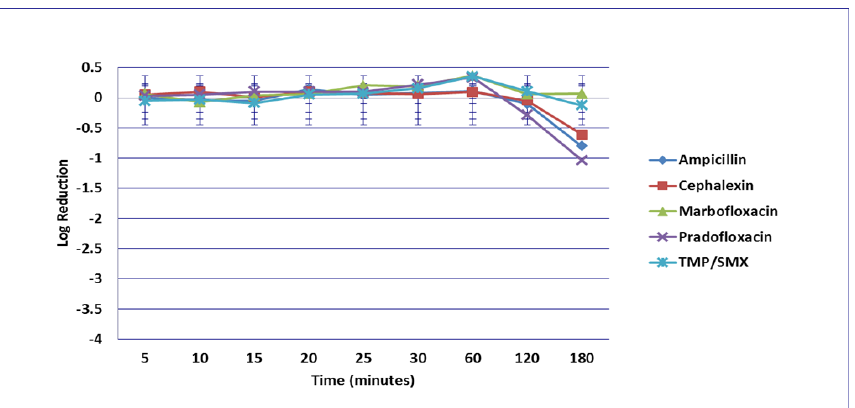
Figure 5. Log 10 reduction in E. faecalis with bacterial cells exposed to ampicillin, cephalexin, mar- bofloxacin, pradofloxacin, and trimethoprim/sulfamethoxazole at the minimum inhibitory drug concentration. Data points present mean ± standard deviation.